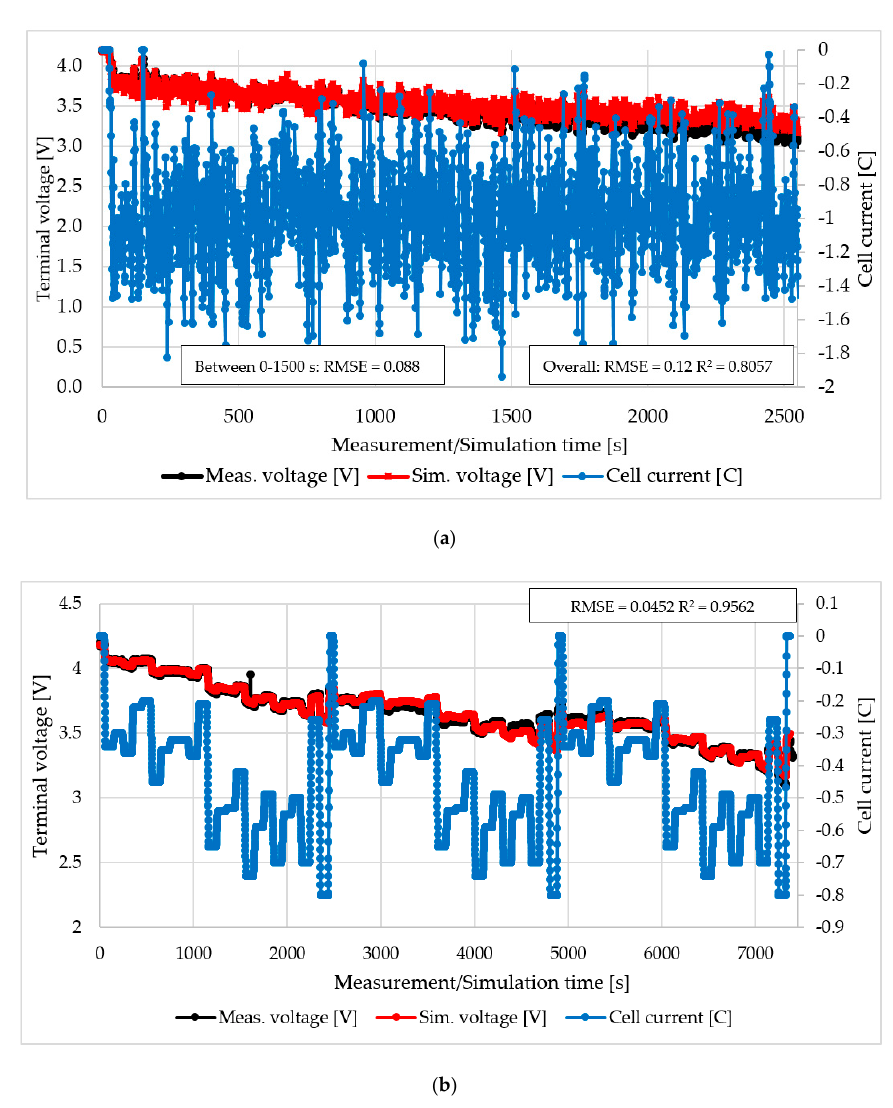
Figure 9. Comparison of the measured and simulated terminal voltage when estimated electrochemical values were applied in the DFN model. ( a ) An average of 1 C transient discharge; the diffusion coefficient changes in the function of Li-ion concentrations in the solid and the electrolyte which effect can be observed between 1500 s–2600 s. ( b ) An average of 0.3 C discharge with repetition of discharge profiles.